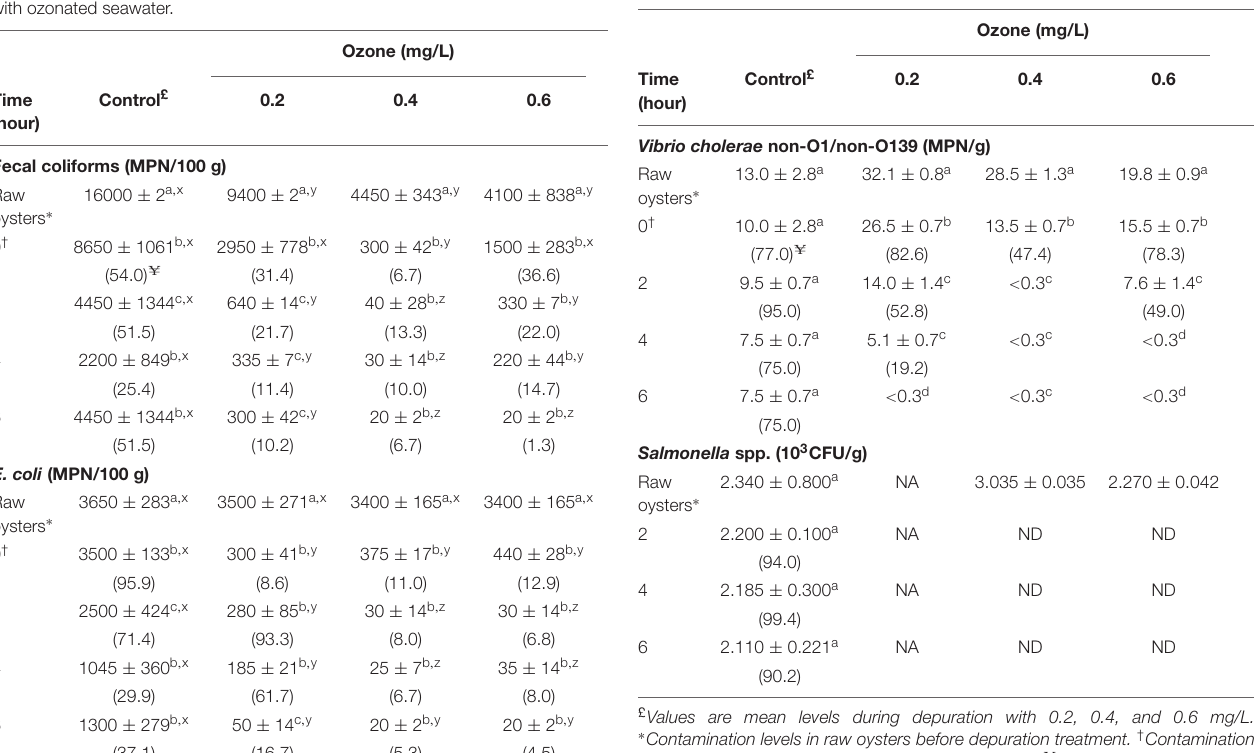
TABLE 2 | Effect of ozone depuration on Vibrio cholerae non-O1/non-O139 and Salmonella spp. in naturally contaminated American